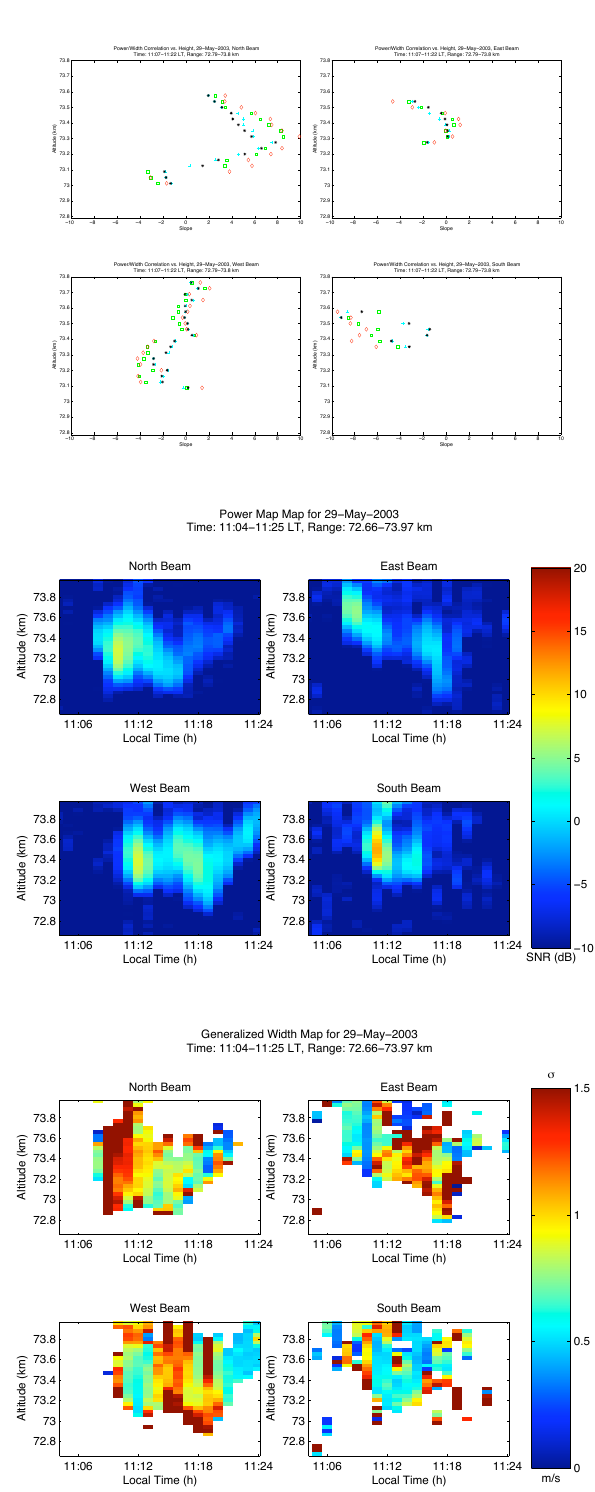
Fig. 20. SNR map and spectral width map of event at 73.4km on May 29, 2003 at 11:10 LT.